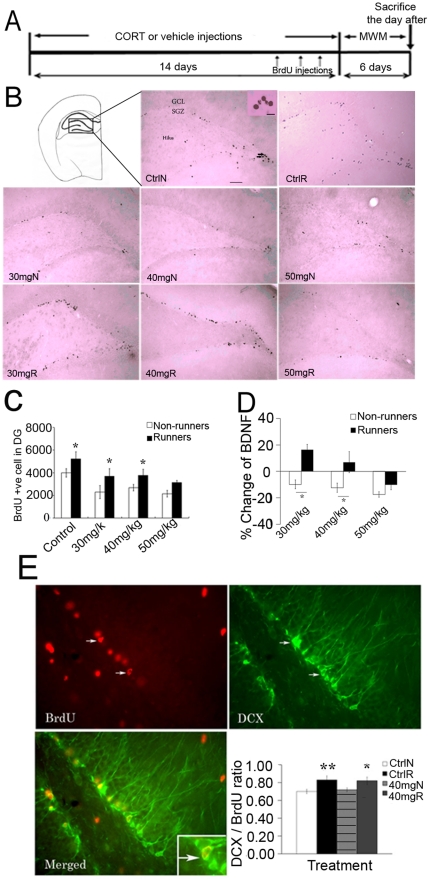
Hippocampal cell proliferation and neurogenesis in the dentate gyus.(A) A schematic diagram depicting experimental procedures for the treatment. MWM: Morris water maze (B) Representative images of BrdU-labelled cells. (C) CORT significantly suppressed hippocampal cell proliferation, whereas running reversed the decrease in vehicle-, 30 mg/kg and 40 mg/kg CORT-treated rats. *P<0.05 compared to non-runner counterparts. (D) There was no difference in hippocampal BDNF level between vehicle-treated runners and non-runners. However, BDNF level was decreased by CORT in a dose-dependent manner. Running up-regulated BDNF level in 30 mg/kg and 40 mg/kg CORT-treated rats, but not in 50 mg/kg CORT-treated rats. Data are expressed as percentage change±S.E.M. *P<0.005 compared to non-runner counterparts. (E) Running increased neuronal differentiation of newborn cells while CORT treatment showed no effect. *P<0.05, **P<0.005 compared to control non-runners. Values are respresented as mean±S.E.M. Ctrl: control; 30–50 mg: dosages of CORT treatment; N: non-runner; R:runner. Scale bar = 50 µm. N = 6–8/group.